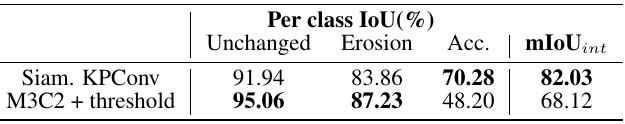
Table 4. Quantitative results for Siamese KPConv and M3C2 methods for change detection and categorization. Acc. stands for accumulation.